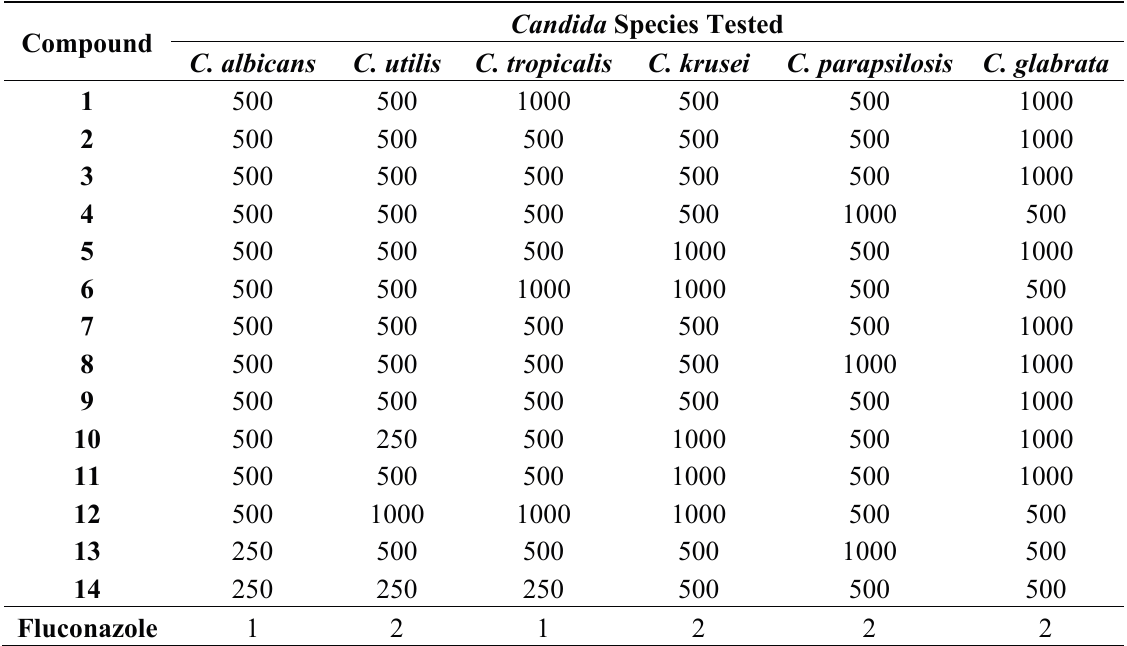
Table 2. The anticandidal activity of the compounds 1 – 14 expressed as MIC values (µg/mL). Compound